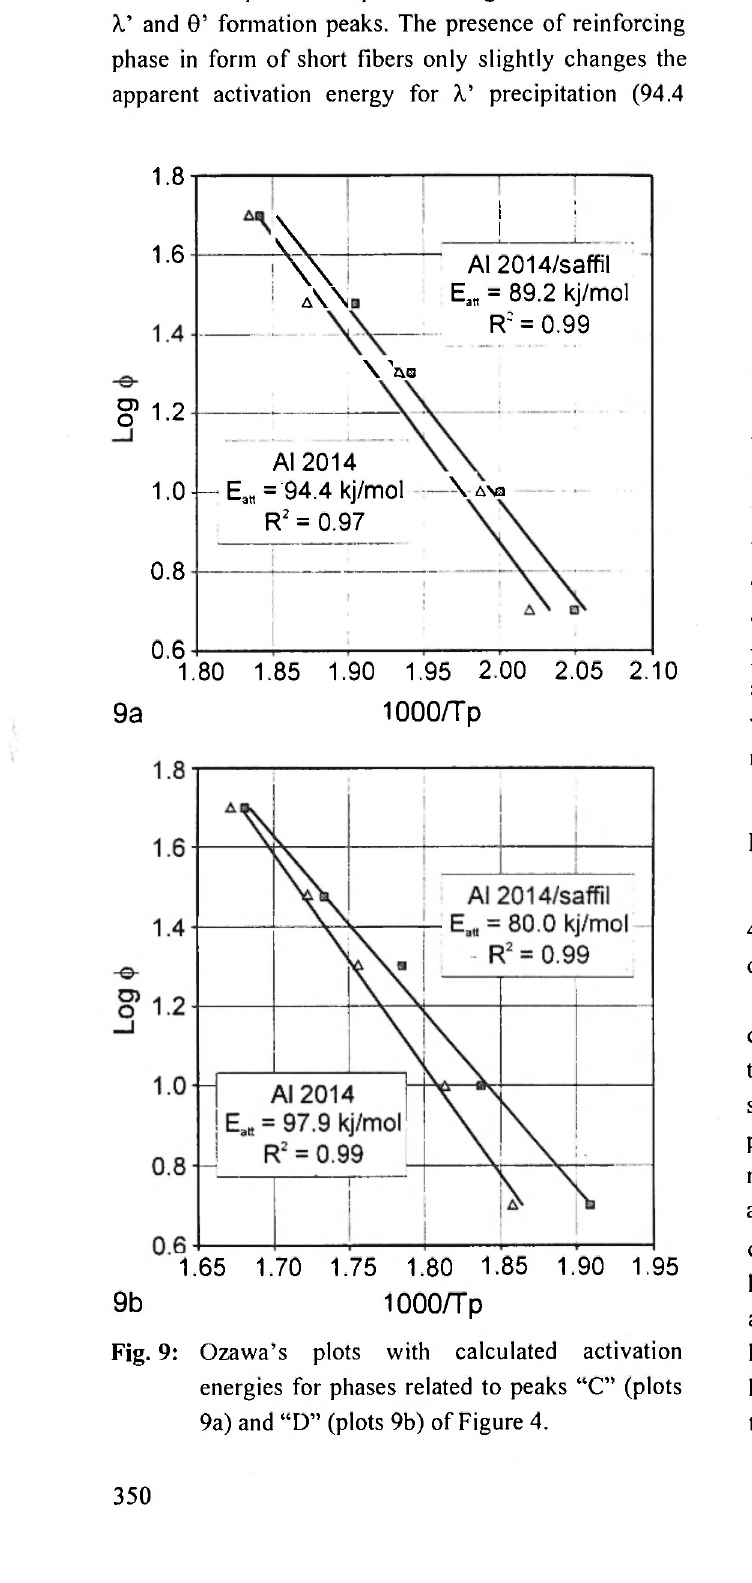
Fig. 9: Ozawa's plots with calculated activation energies for phases related to peaks "C" (plots 9a) and "D" (plots 9b) of Figure